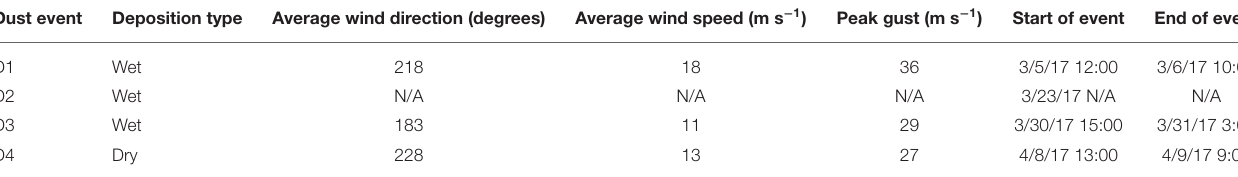
TABLE 2 | Description of weather events in which a dust deposition event occurred and snow samples were